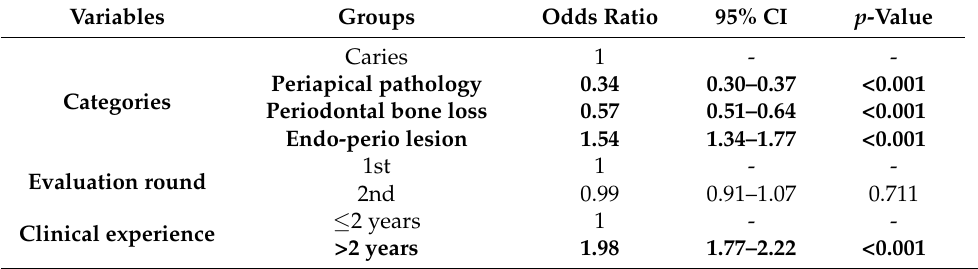
Table 6. Adjusted odds ratio with corresponding 95% CI and p -values were calculated according to the logistic regression model using backwards elimination. Bold numbers represent a significant